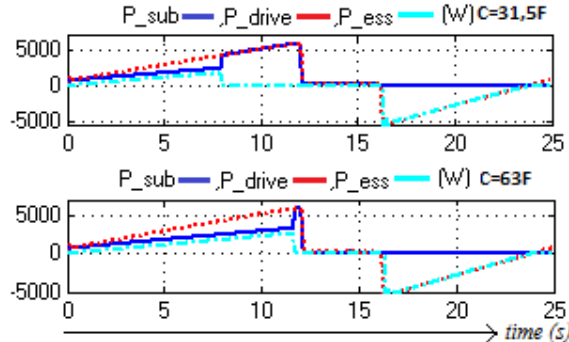
Fig. 14. Simulation diagrams for V SC = 198.15 V when C = 31.5 F and for V SC = 192.06 V when C = 63 F.